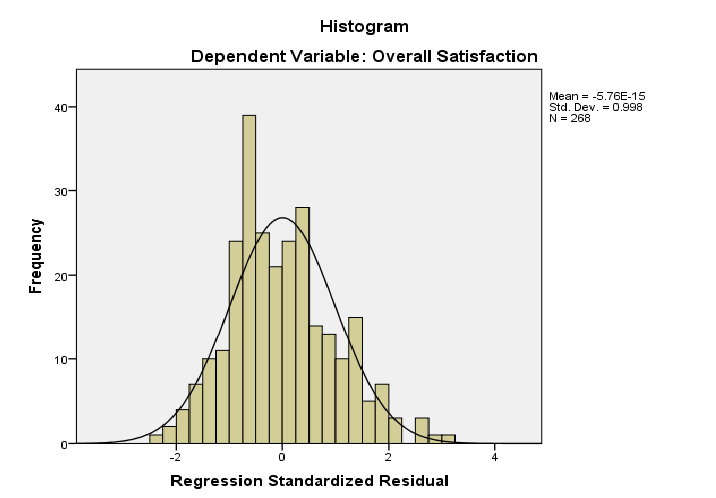
Figure 2: Normality tests for process focus